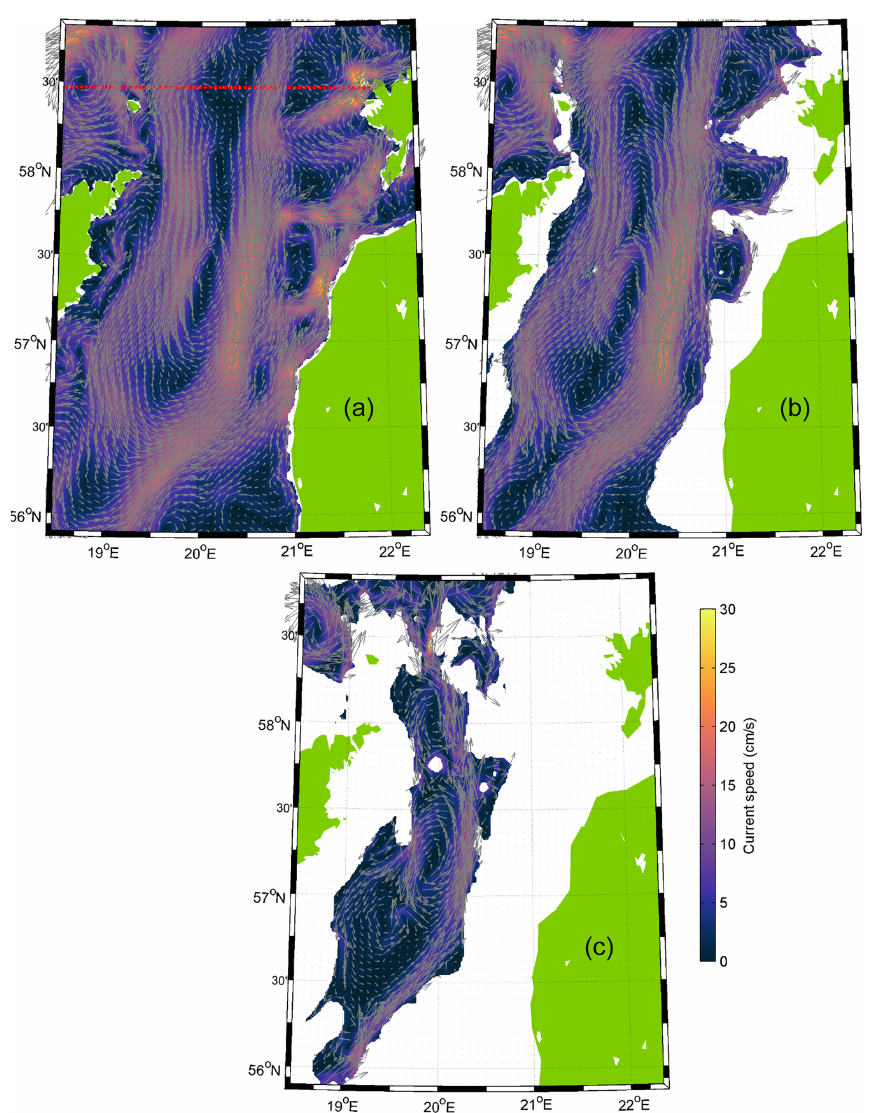
Figure 9. Mean simulated currents in the case of prevailing southwesterly winds from 1 to 21 March 2020 without the thermocline at 5 (a) , 40 (b) , and 110m depth (c) . The color scale shows current speed in centimeters per second (cms − 1 ). The red dashed line in panel (a) shows the location of the transect presented in Figs. 8 and